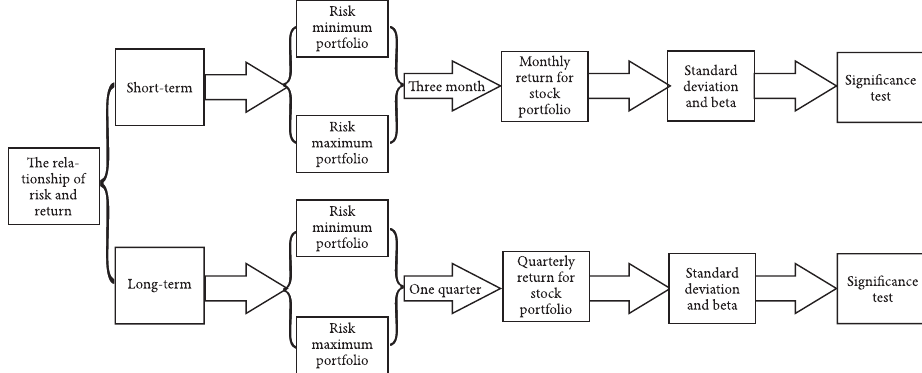
Figure 1. The flowchart of the